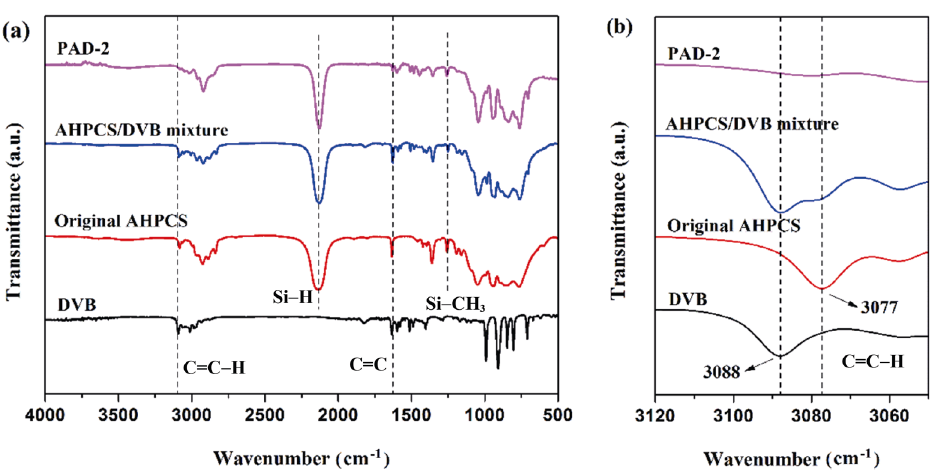
Fig. 2 FT-IR spectra of original AHPCS, DVB, unreacted AHPCS/DVB mixture, and single-source-precursor